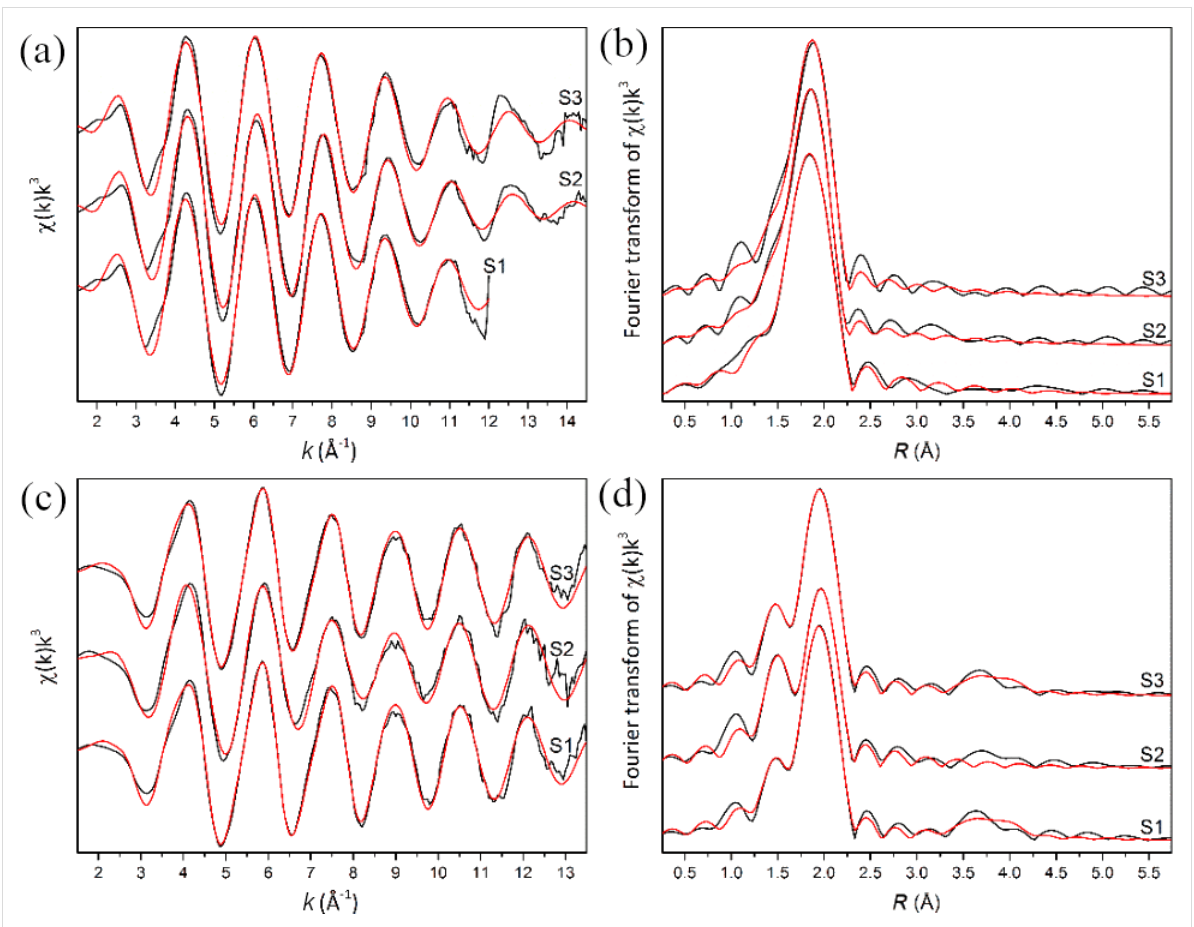
Figure 5: Cu (a,b) and Sn (c,d) K-edge EXAFS (a,c) and Fourier transform (b,c) of the studied samples. The experimental data are reported as black lines and the red lines represent the fits.